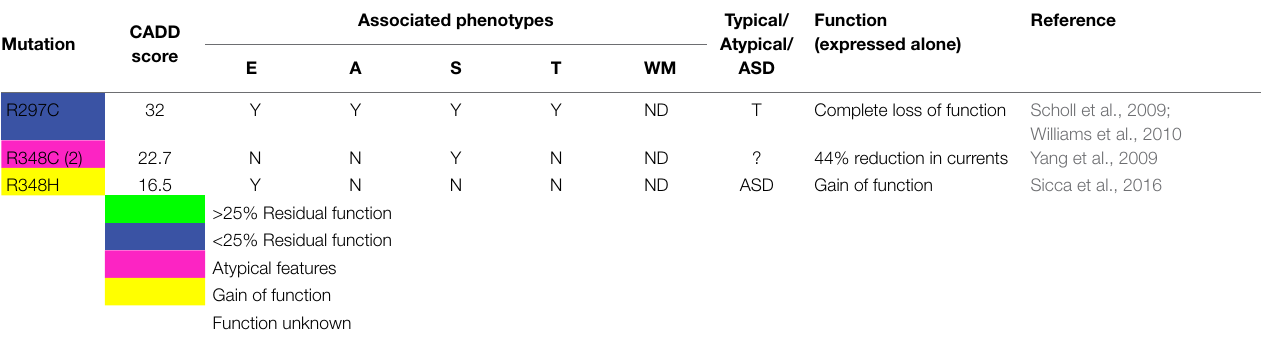
Table 1 summarizes the consequences of KCNJ10 mutations. CADD score according to https://cadd.gs.washington.edu/snv (Rentzsch et al., 2019). Associated phenotypes refer to epilepsy (E), ataxia (A), sensorineural deafness (S), tubulopathy, hypokalemia and alkalosis (T), white matter abnormalities (WM), and autism spectrum disorder (ASD). Yes (Y); No (N); Not determined (ND). * indicates a “stop codon”. Color code is shown for functional effects when expressed as homomeric Kir4.1. Note that pink coloration was given to “atypical” (=A) mutations which lead to partial EAST syndrome, that is, lack some of its characteristic features, as opposed to “typical,” featuring all cardinal symptoms Epilepsy,